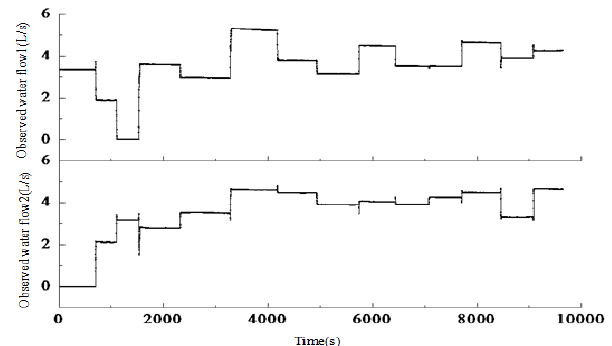
Fig. 4. Observation Signals (1. regional total input volume, 2. main branch volume) of Flow Meters